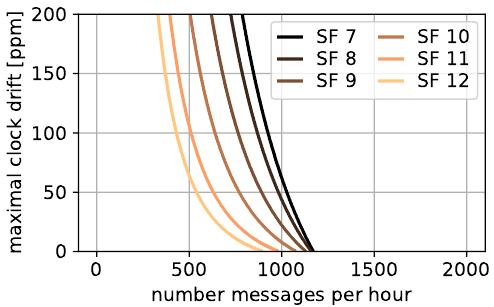
Figure 4. T d to messages